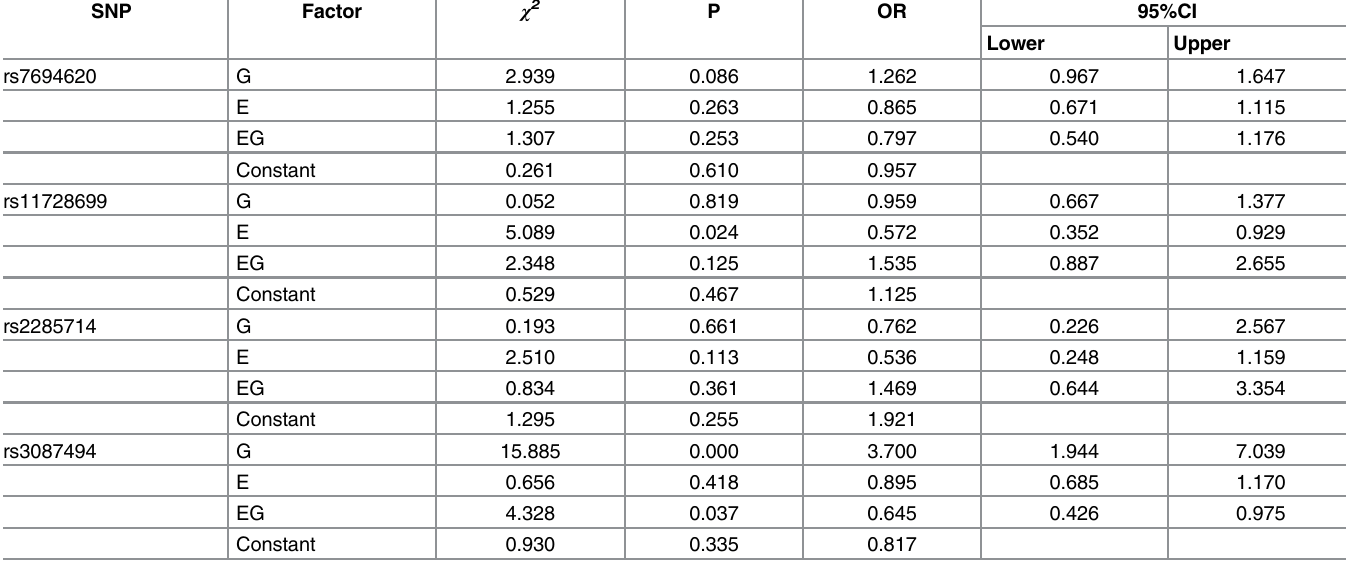
Table 6. Logistics regression of the interaction between SNPs in PLA2G12A.and